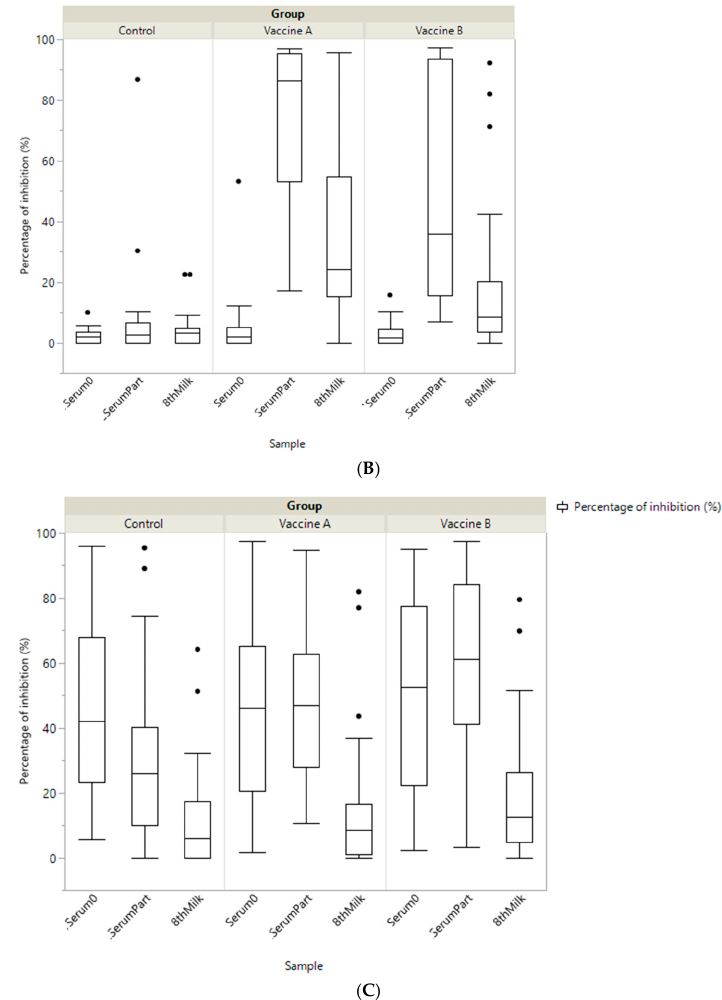
Figure 1. Boxplot showing specific immunity represented as percentage of inhibition (PI) of antibody titre including the different samples (Serum0, SerumPart and 8thMilk) by study group (Vaccine A, Vaccine B and Control) against: ( A ) coronavirus (BoCV); ( B ) enterotoxigenic E. coli (ETEC F5 (K99)) and ( C ) Rotavirus (BoRV).